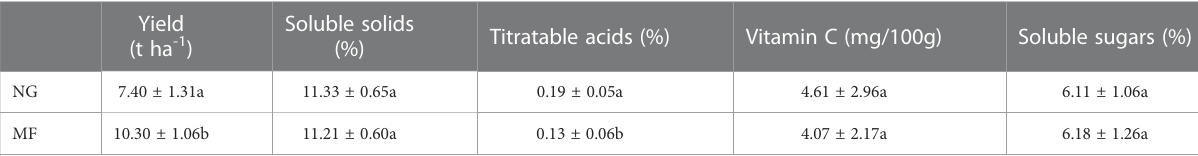
TABLE 3 Effect of different cultivation modes on pear yield and quality.